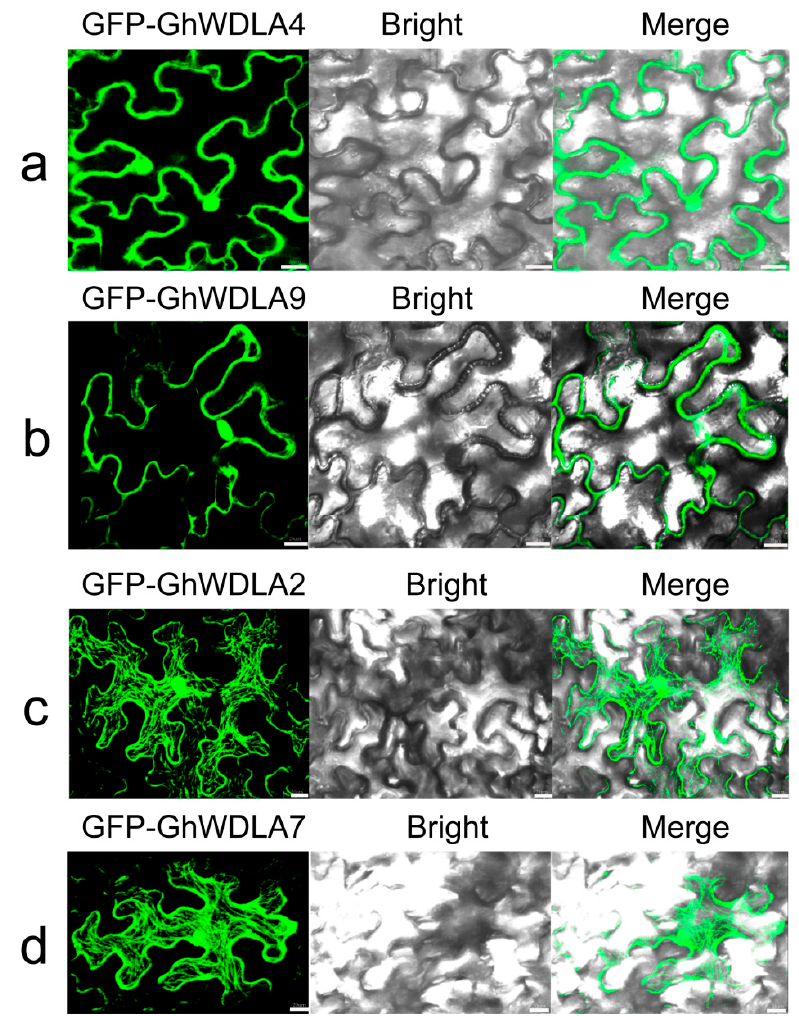
Figure 8. Subcellular localizations of four selected TPX2 proteins in the epidermal cell of tobacco leaf: ( a ) GFP-GhWDLA4: ( b ) GFP-GhWDLA9: ( c ) GFP-GhWDLA2, and; ( d ) GFP-GhWDLA7. Scale bar = 20 µm.